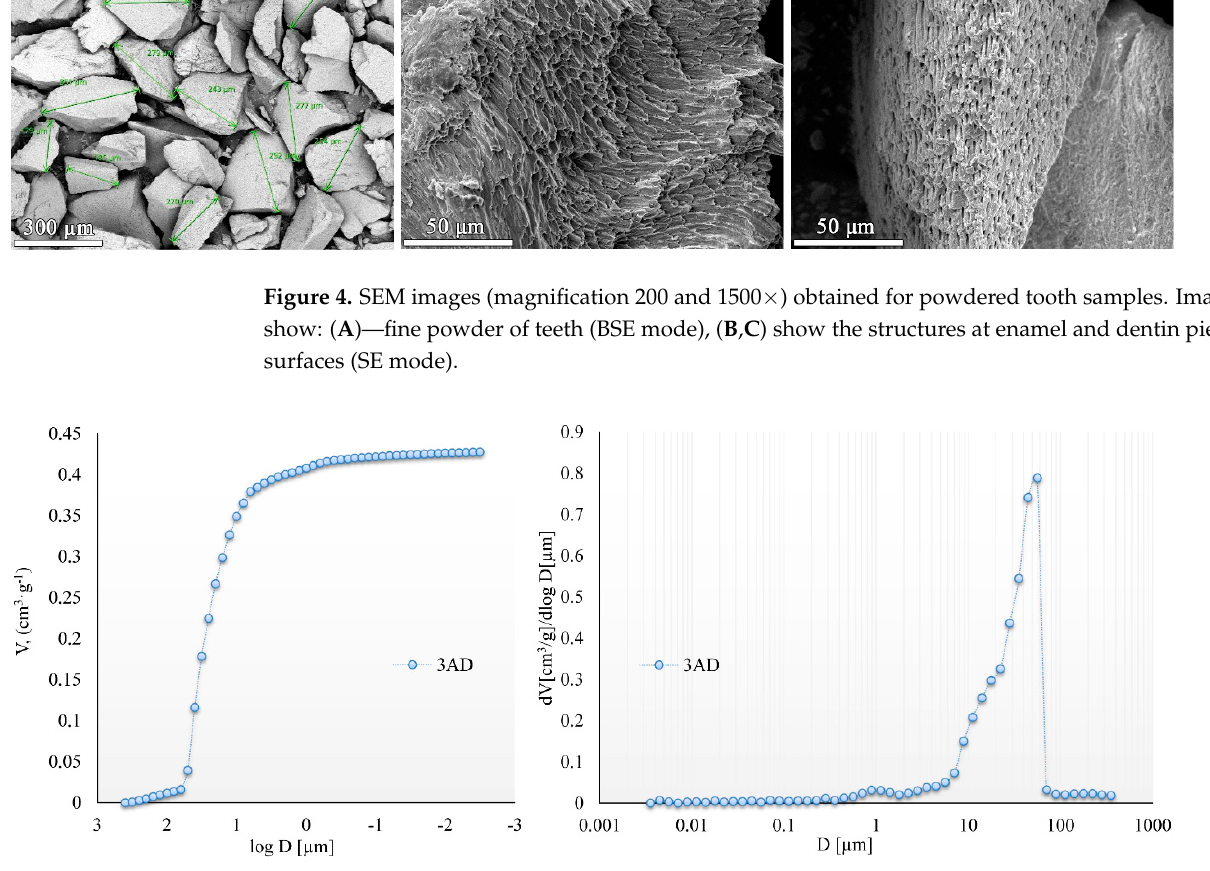
Figure 4. SEM images (magnification 200 and 1500×) obtained for powdered tooth samples. Images show: ( A )—fine powder of teeth (BSE mode), ( B , C ) show the structures at enamel and dentin pieces surfaces (SE mode).